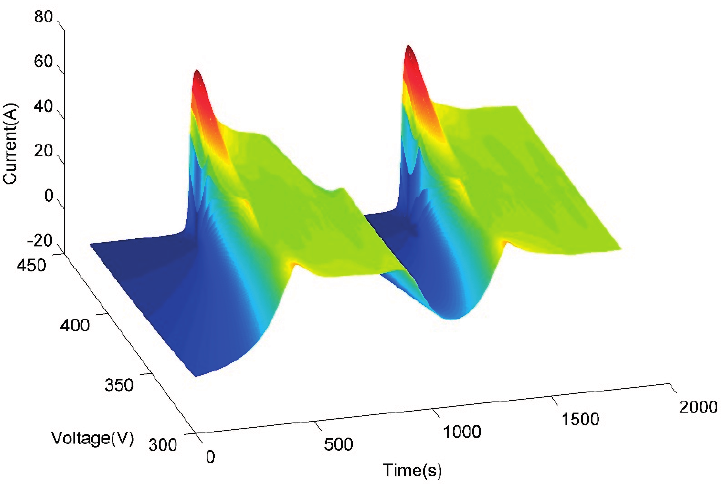
Figure 11. The surface chart of voltage and electrical current received during 30